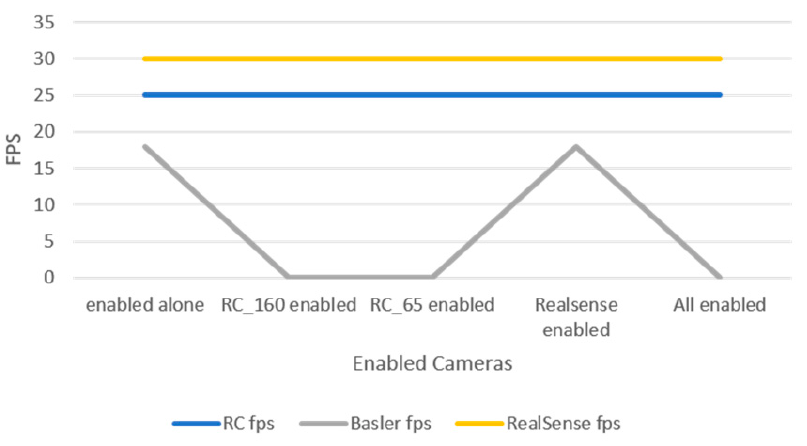
Figure 17. Frames per second (FPS) of active cameras .